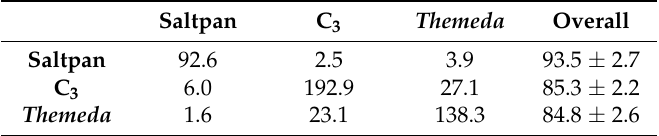
Table A3. Mean confusion matrix for Landsat OLI three-class classification results. Confusion values are given as a count value, and overall accuracies as a percentage with standard